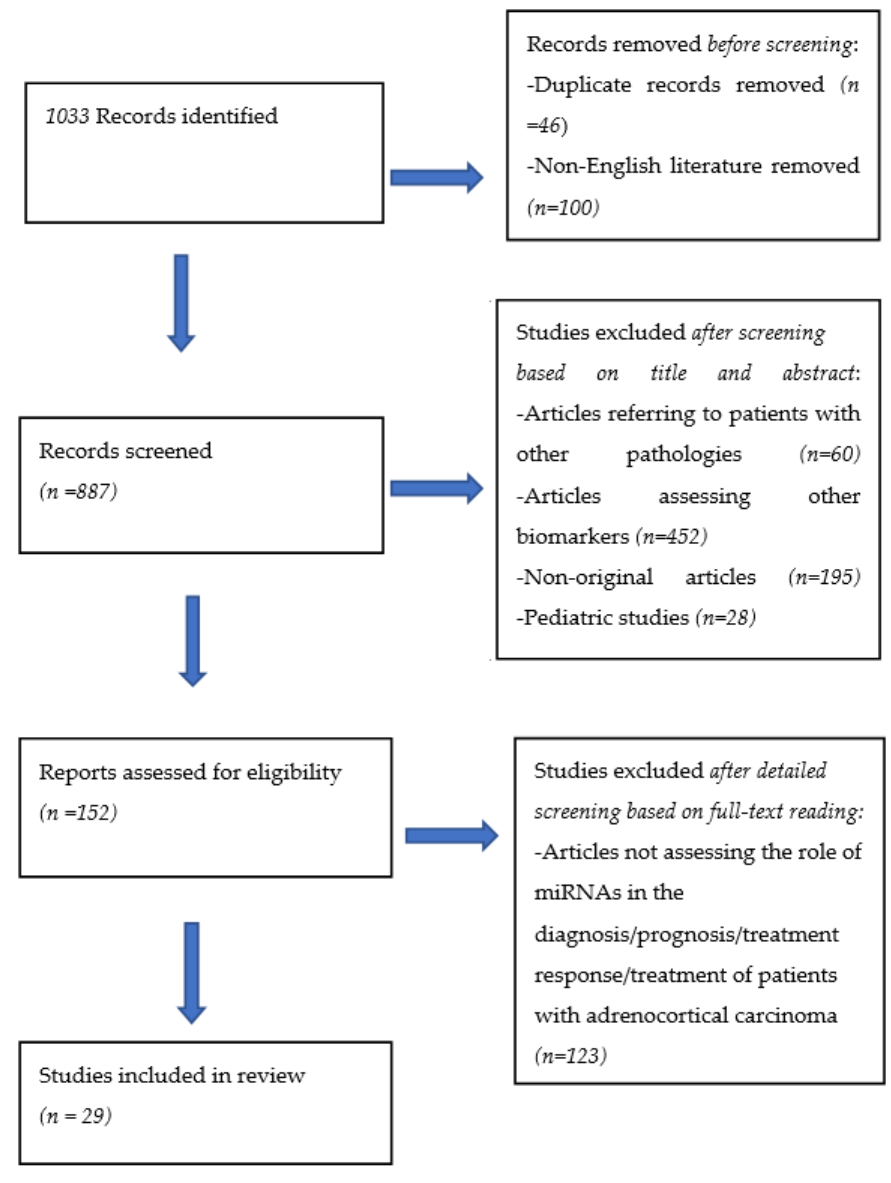
Figure 1. PRISMA flow diagram.